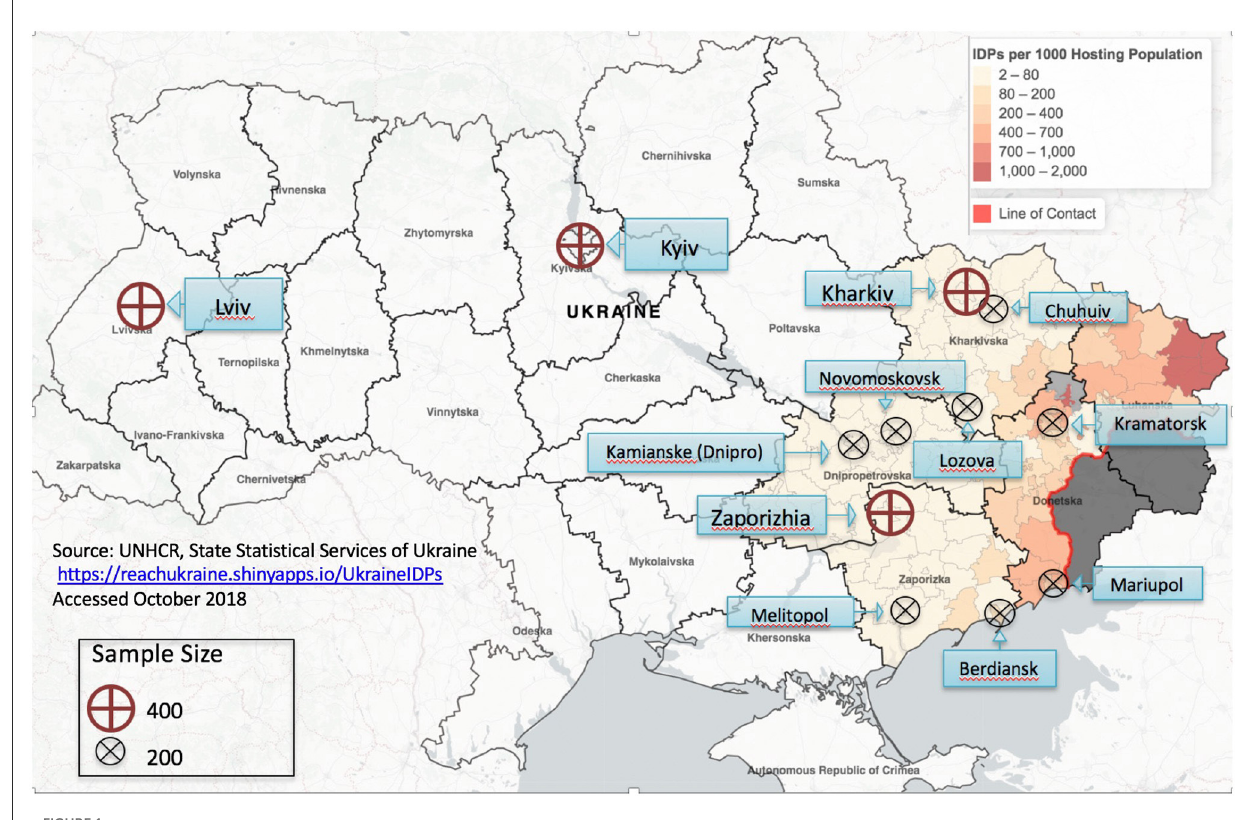
FIGURE1 Survey sample sites.